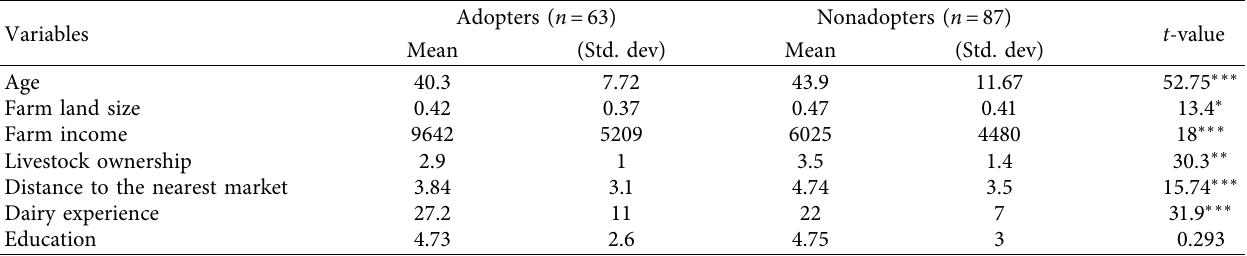
Table 6: Statistical summary of sampled adopters and nonadopters on continuous variables.